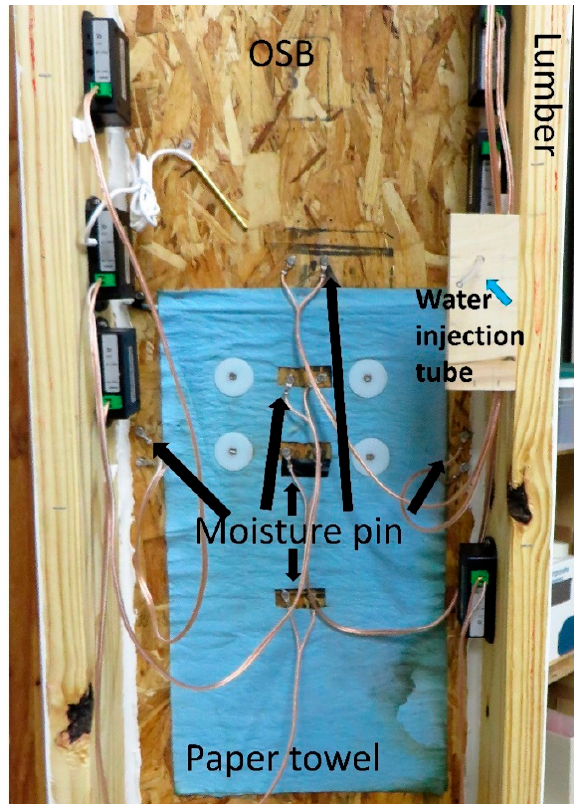
Figure 2. Photograph of paper towel wetting system with moisture pins in cavity.